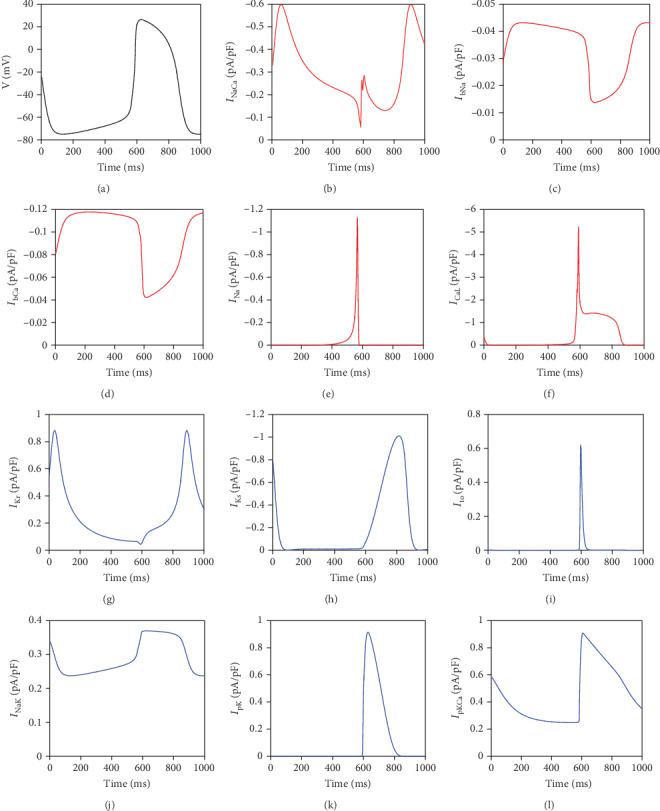
Simulated spontaneous AP in the TNNP ventricular cell model with IK1 reduction (GK1 was set to 0.05 nS/pF) and the underlying ion channel currents. (a) AP. (b) INaCa. (c) IbCa. (d) IbNa. (e) INa. (f) ICaL. (g) IKr. (h) IKs. (i) Ito. (j) INaK. (k) IpK. (l) IpCa.